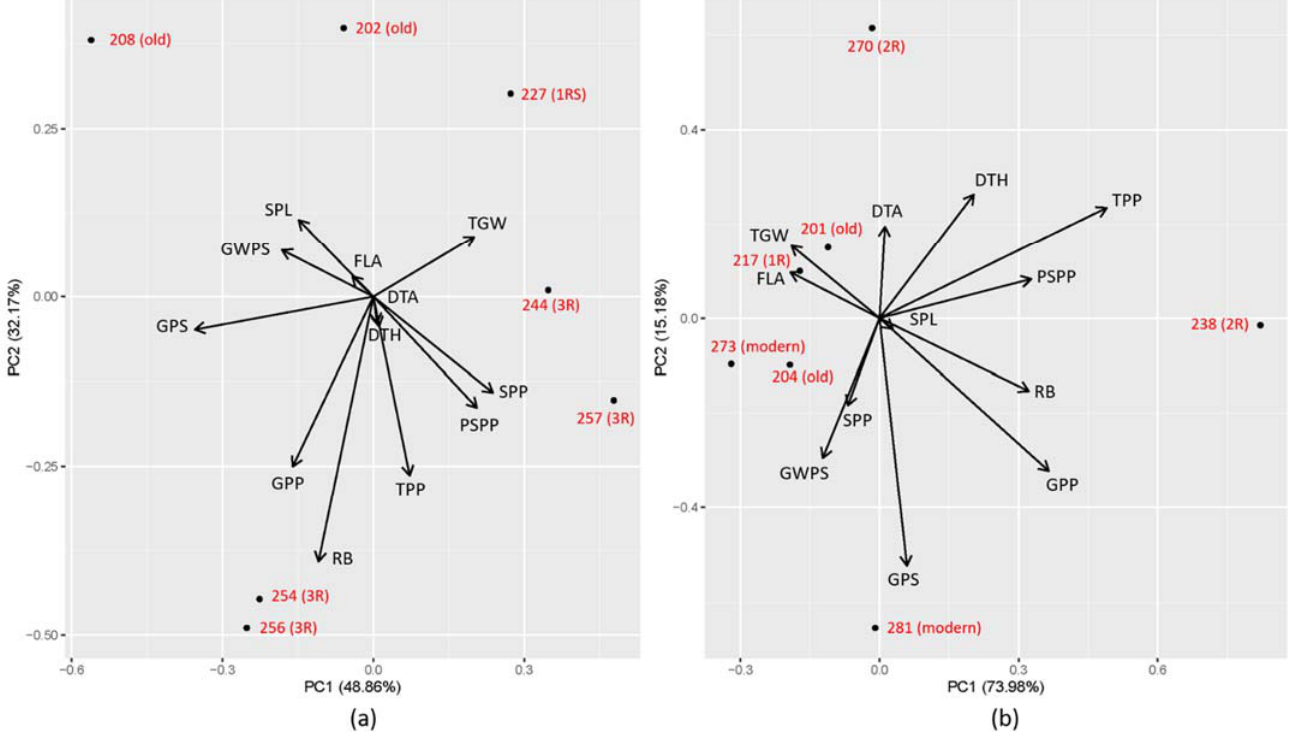
Figure 6. Principal-component analysis (PCA) for stress-tolerance index (STI) of all traits except grain weight per plant (GWPP) with the top 10% genotypes selected by stress-tolerance index (STI) of GWPP under ( a ) early drought stress (EDS) and ( b ) late drought stress (LDS). Modern = approved cultivars and breeding lines received from company Lantmännen, Old = cultivars released from 1928 to 1990, 1R = introgressions of chromosome 1R, 1RS = introgressions of chromosome 1RS, 2R = introgressions of chromosome 2R, 3R = introgressions of chromosome 3R.